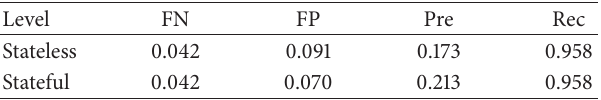
Table 3: Detection accuracy for the stateless level versus stateful